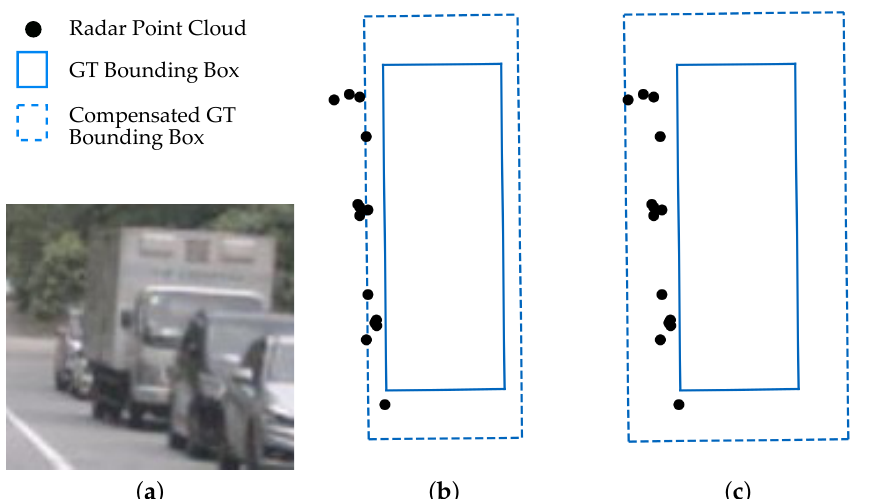
Figure 6. Compensating the misalignment of the manually labeled ground-truth bounding box with a wlh -tolerance creates a more precise ground-truth for the network training. ( a ) The truck of interest in camera view. ( b ) BEV: The wlh -factor = 1.3 includes only 5 points in the compensated GT bounding box. ( c ) BEV: The wlh -tolerance = 1.2 includes all 14 points in the compensated GT bounding box. NuScenes sample token: